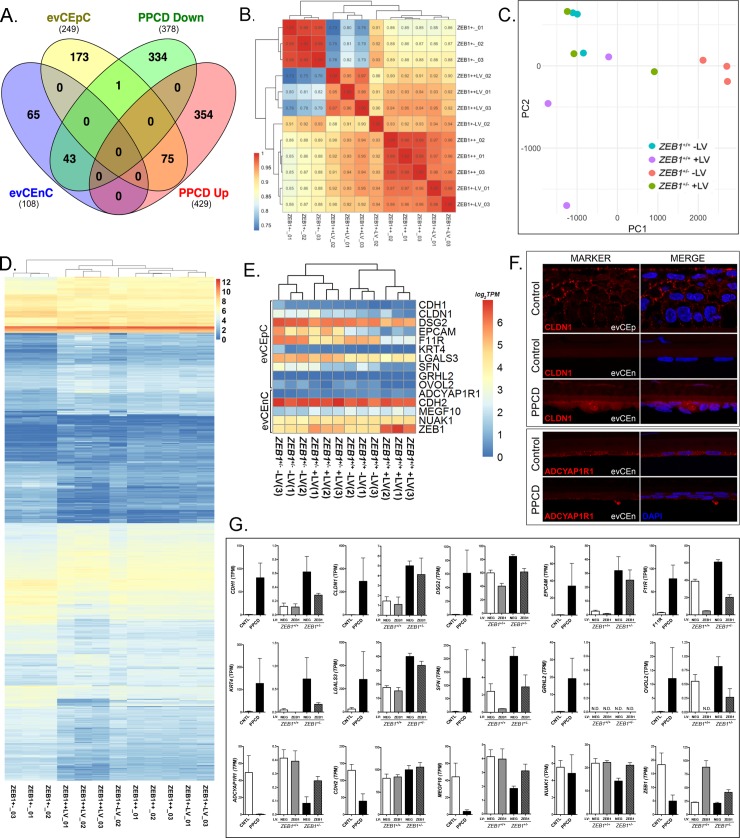
Transcriptomic analysis of the ZEB1+/- CEnC line validates it as a model of PPCD.(A) Venn diagram comparing genes specifically expressed by ex vivo corneal epithelial cells (evCEpC) and ex vivo corneal endothelial cells (evCEnC) with differentially expressed genes in PPCD. (B) Spearman correlation heat map, (C) principle component analysis, and (D) heat map demonstrating clustering analysis of the four ZEB1 CEnC lines and a combined list of 1031 genes that showed significant differential expression in at least one of the three cell lines (ZEB1+/+ +LV, ZEB1+/- -LV, and ZEB1+/- +LV) compared with ZEB1+/+. (E) Hierarchical clustering heat map of selected epithelial- and endothelial-specific genes and ZEB1 CEnC lines. (F) Immunofluorescence showing expression of the epithelial-associated protein CLDN1 and the corneal endothelial-associated protein ADCYAP1R1 in PPCD endothelium. Expression of CLDN1 in corneal epithelium (evCEp) was used as a positive control. CLDN1 and ADCYAP1R1 were visualized with Alexafluor 594 (red), and nuclei were stained with DAPI (blue). (G) Bar graphs showing the expression of selected epithelial- and endothelial-specific genes (see (E)) in PPCD endothelium (n = 3) and in the ZEB1 CEnC lines (n = 3). Gene expression is given in TPMs.